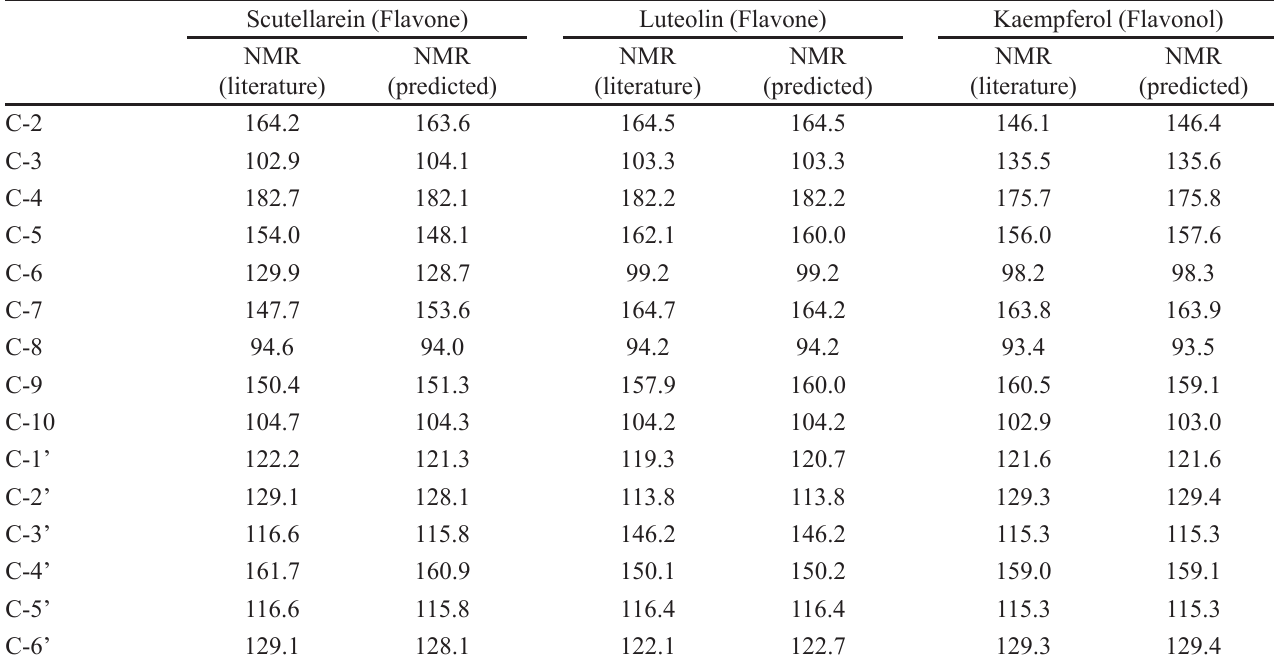
TABLE II - Use validation of the ACDlab software to predict NMR